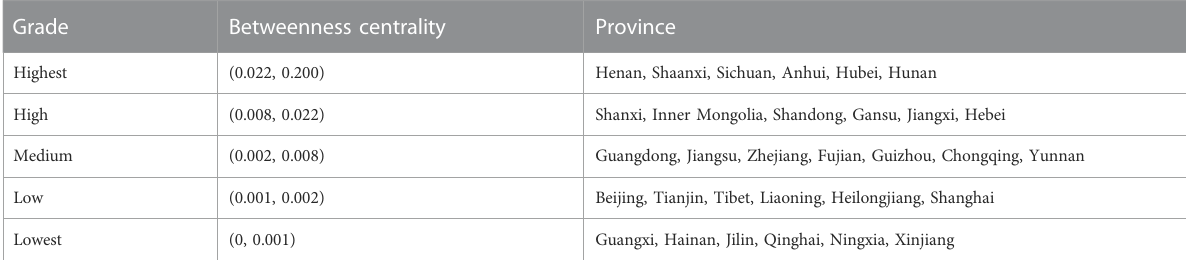
TABLE 4 Spatial distribution of betweenness